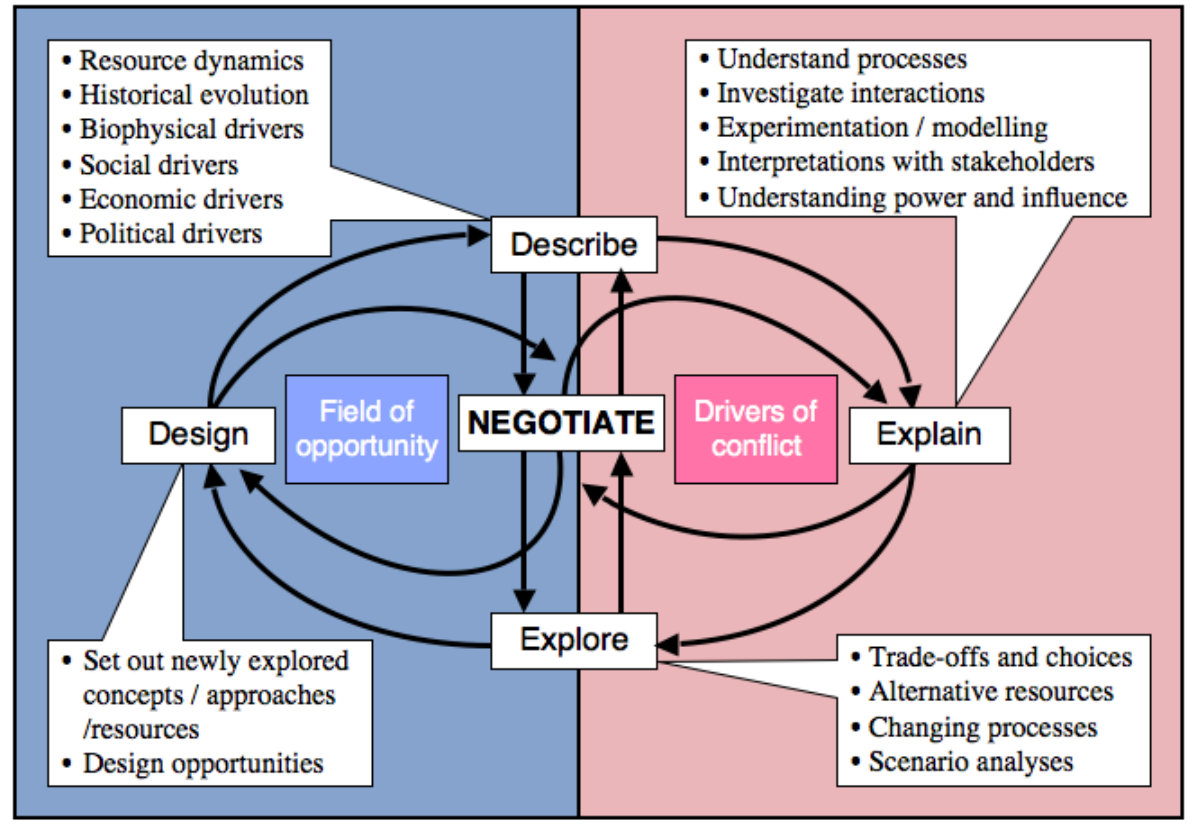
Fig. 2. The analysis of competing claims on natural resources: an iterative cycle of stakeholder- negotiated research phases